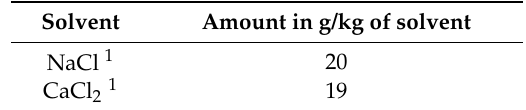
Table 2. CaCl 2 -NaCl Solution